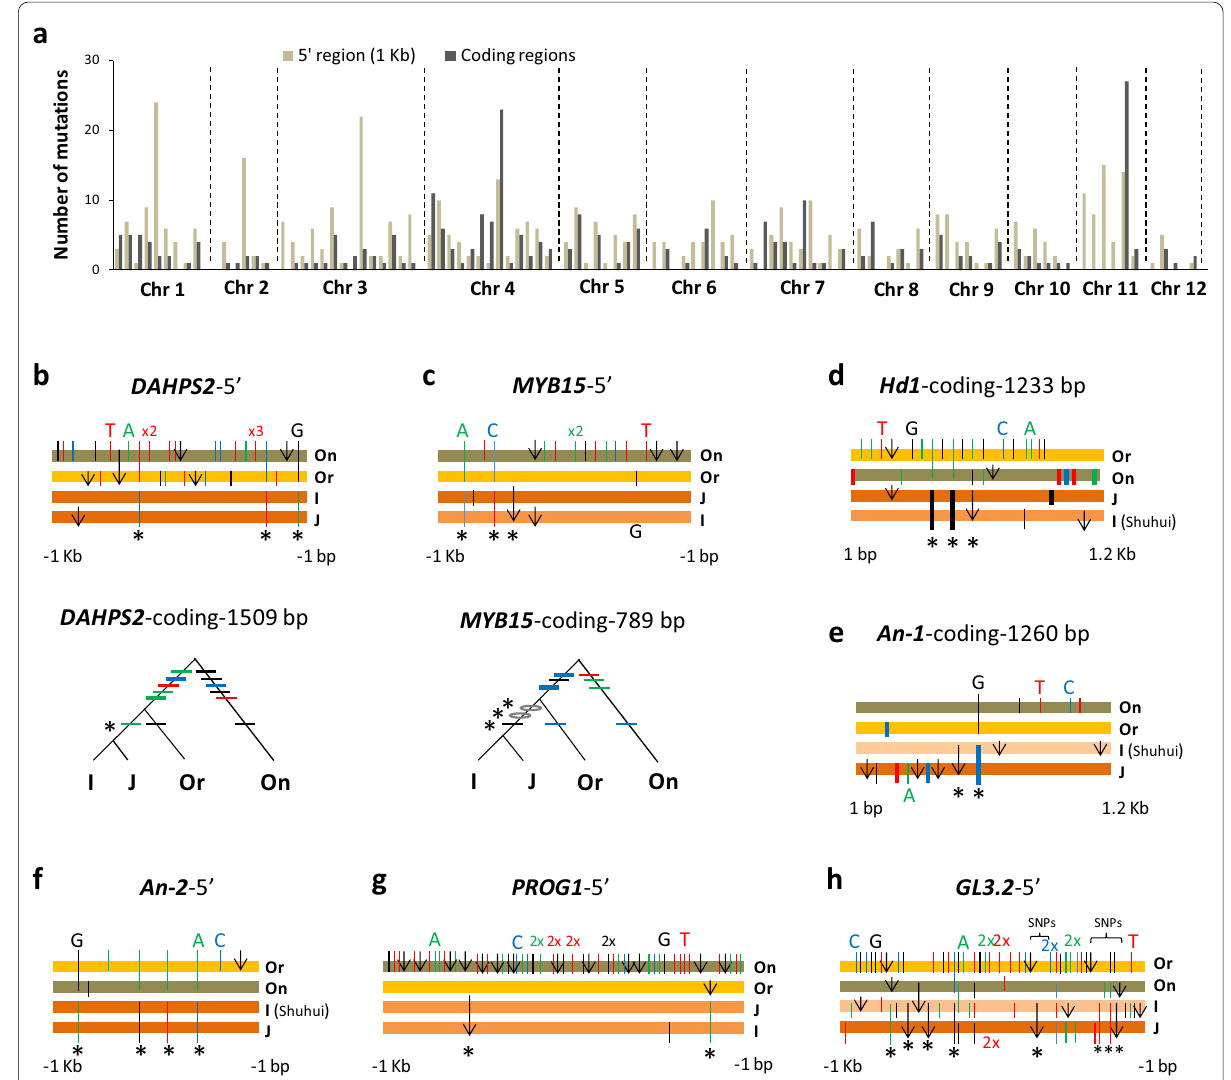
Fig. 1 Identification of early mutations in O. sativa . a Manhattan plot of 756 Os mutations on 101 genes distributed across rice chromosomes (chr1–chr12). Details on sampled genes see Additional file 1: Table S1. b – h Gene genealogies of seven genes showing early mutations (in asterisks). Gene genealogies connecting indica (I) and japonica (J) of O . sativa to its wild relatives ( O. rufipogon (Or) and O. nivara (On)) are shown in bar graph or tree. A graph of horizontal bars shows orthologs in bars and similarities in similar colors, with substitutions coded by colored sticks (A in green, T in red, C in blue, and G in black, and thick ones for nonsynonymous changes) and indels by arrows. A tree-like gene genealogy also uses colored sticks as above for substitutions but circles for indels. Aligned sticks refer to changes at the same nucleotide site. Number of repeated and adjacent changes is shown before x for simplicity. Allele of indica (I) is shown as the identical sequence among three indica genomes or for genome in the parentheses (Shuhui for Shuhui-498); allele of japonica (J) is from the japonica genome. Only the genic regions having early mutations are shown